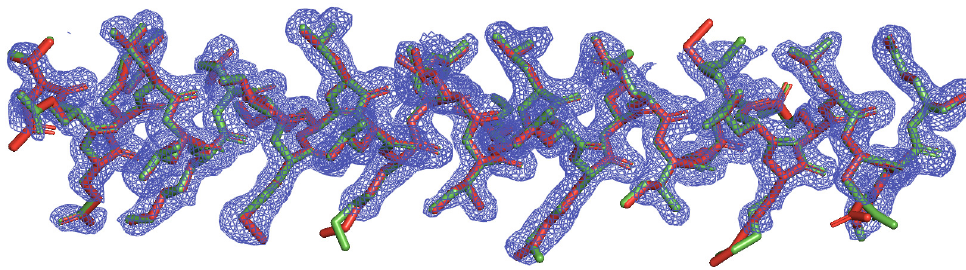
Figure 8. The calculated density map (blue mesh) of an α -helix of 4uot, reconstructed model (green sticks) by ARP/wAPR and PDB posted model (red